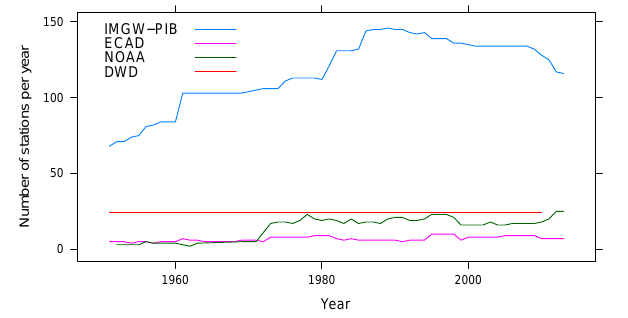
Figure 3. Number of meteorological stations for temperature ob- servations per year from 1951 to 2013.